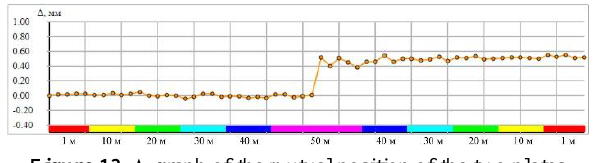
Figure 13. A graph of the mutual position of the two plates relative to the initial one based on the results of processing images taken from different distances.